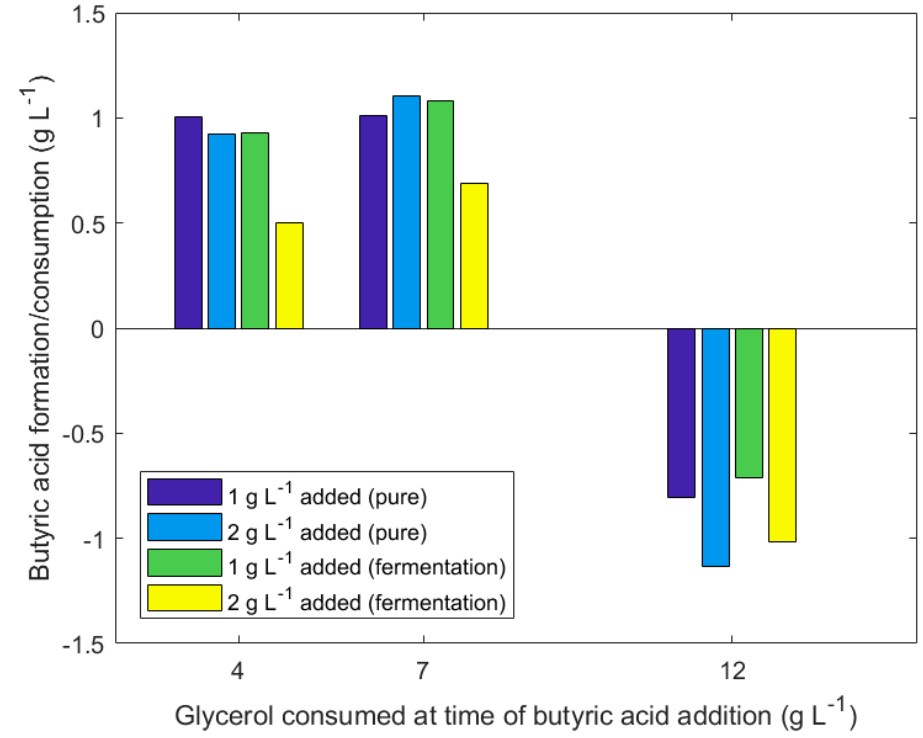
Figure 3. Comparison of the amount of butyric acid produced or consumed when added during fermentation with di ff ering amounts of remaining glycerol.